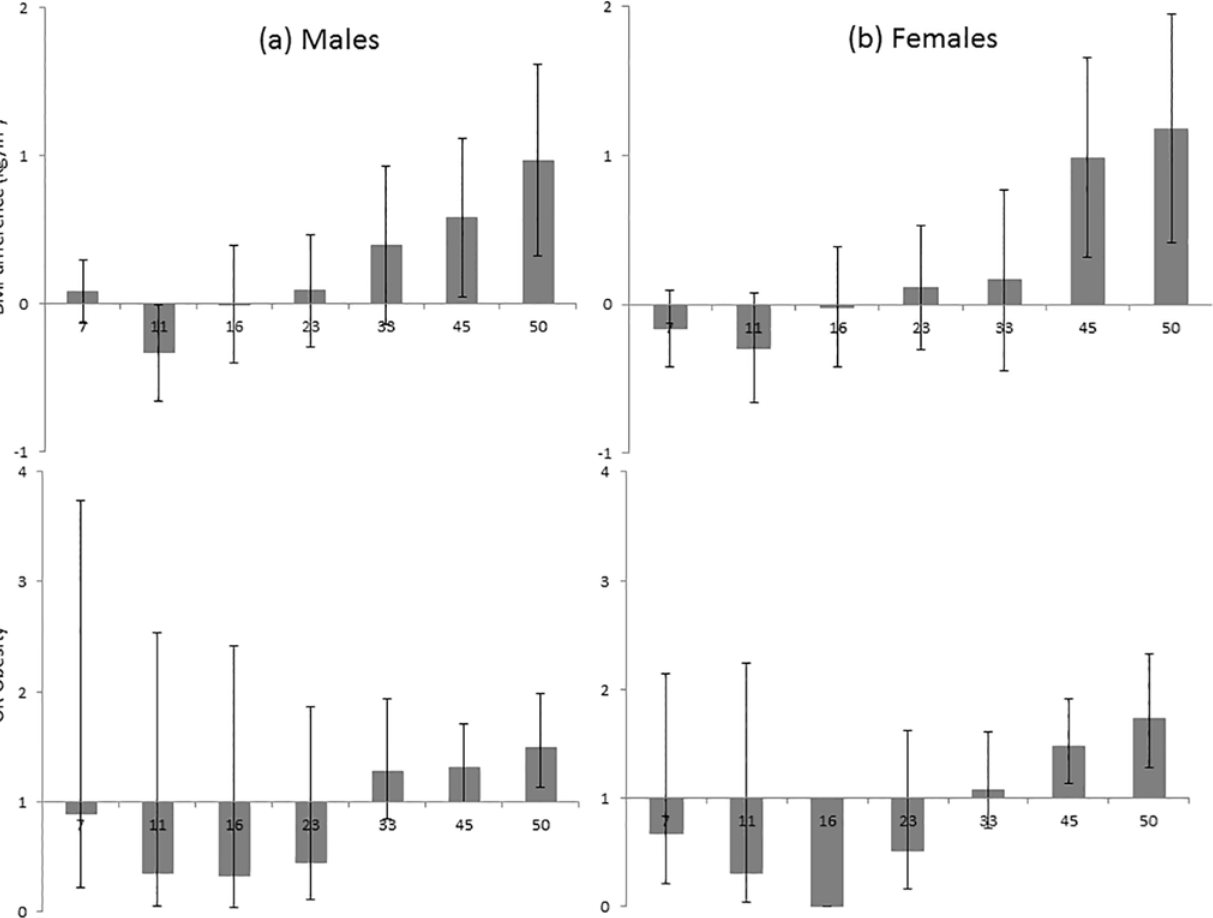
Fig 1. Difference in mean BMI (kg/m 2 ) and OR for obesity (95% CIs) from 7 to 50y by physical abuse † in males and females. Footnotes: † participant report in adulthood (45y) that they had been physically abused by a parent during their childhood before 16y, i.e. punched, kicked or hit or beaten with an object, or needed medical